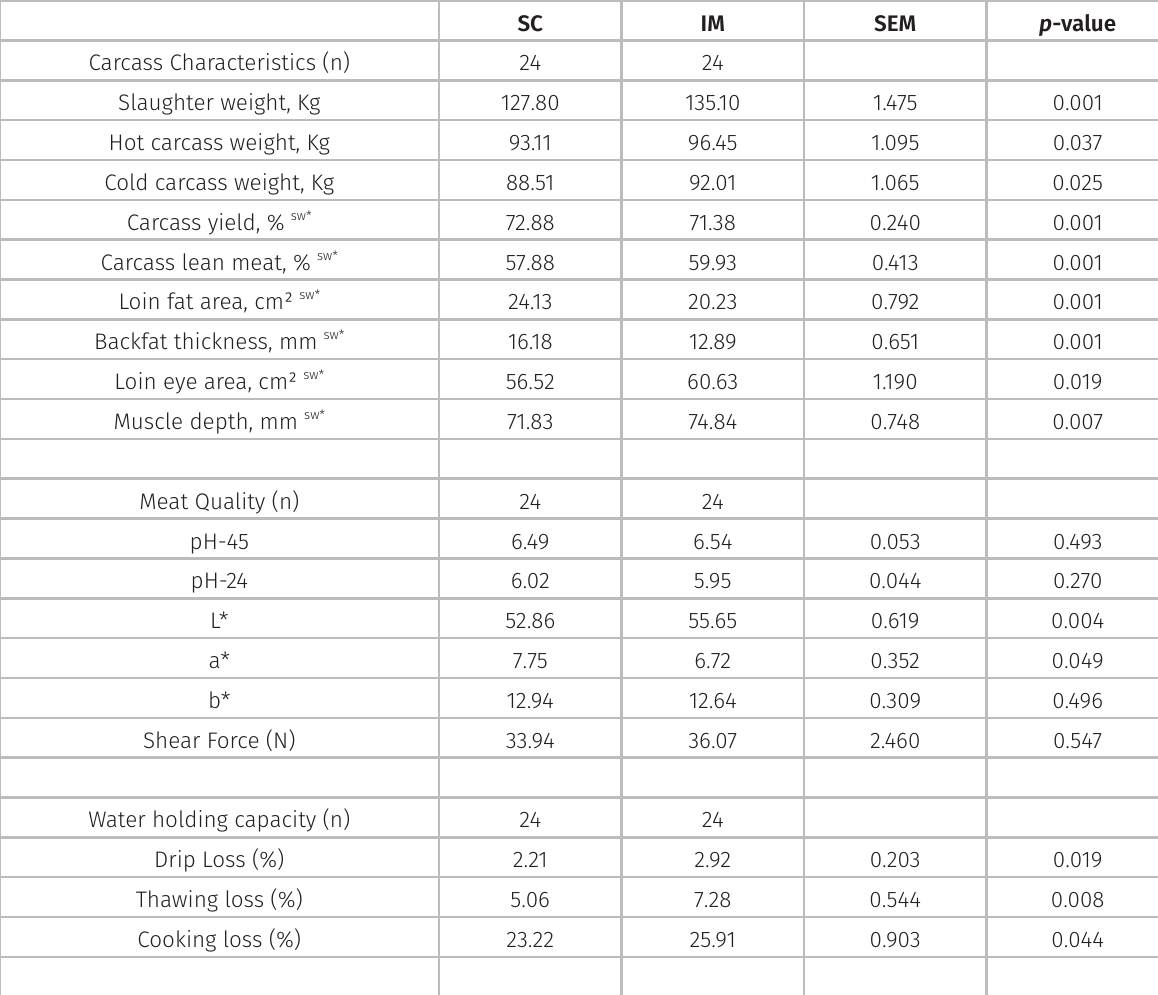
Table II. Carcass characteristics, meat quality and water holding capacity determined in the Longissimus lumborum muscle from swine male surgically castrated and immunocastrated. SC IM SEM p